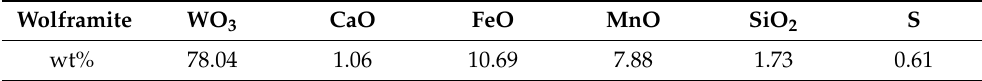
Table 1. The composition of wolframite concentrate analyzed by XRF (wt%).